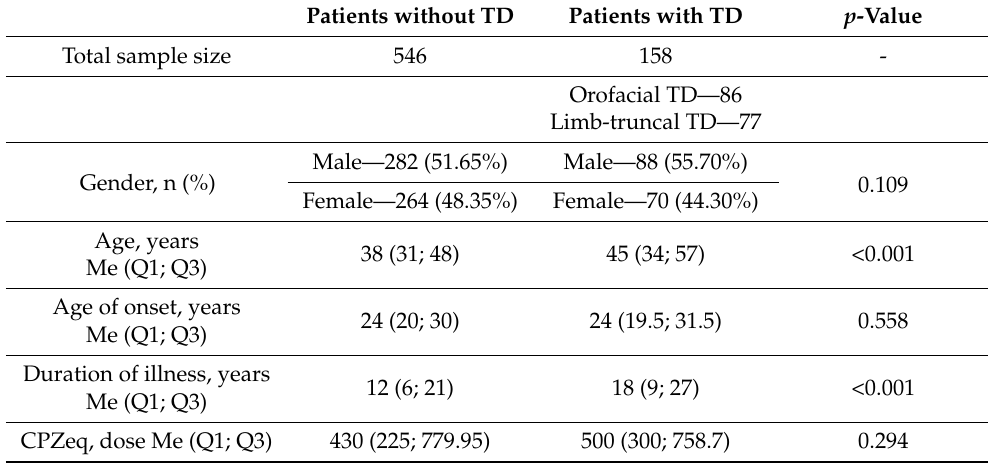
Table 3. Demographic and clinical parameters of the representative group of patients